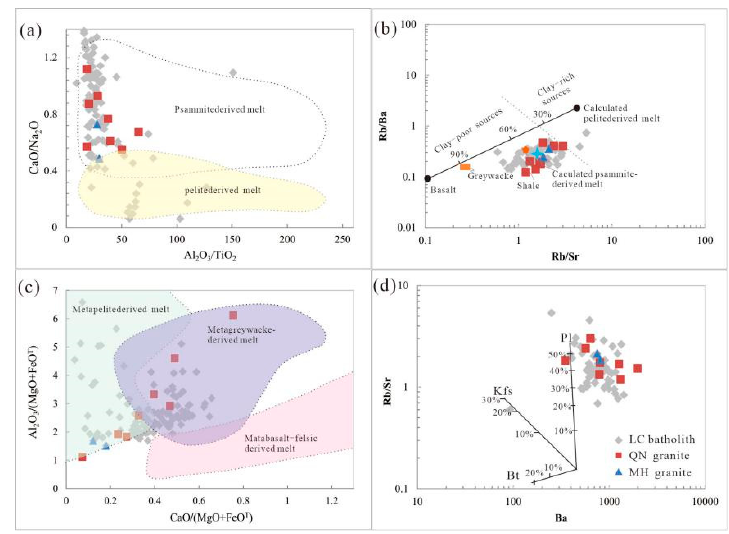
Figure 10. Plots of Al 2 O 3 / TiO 2 versus CaO / Na 2 O ( a ), Rb / Sr versus Rb / Ba ( b ), Ca / (MgO + FeO T ) versus Fig.10 Discrimination diagrams for the potential magma source of the Lincang granite Al 2 O 3 / (MgO + FeO T ) ( c ), Ba versus Rb / Sr ( d ) for the potential magma source of the LC granite (modified from references